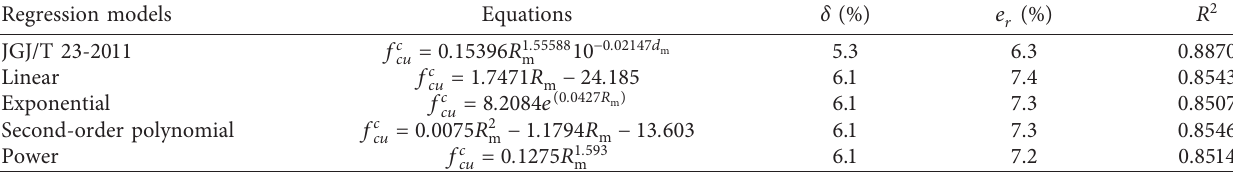
Table 7: Model equations used to estimate the relationship between CFRC compressive strength and RN.